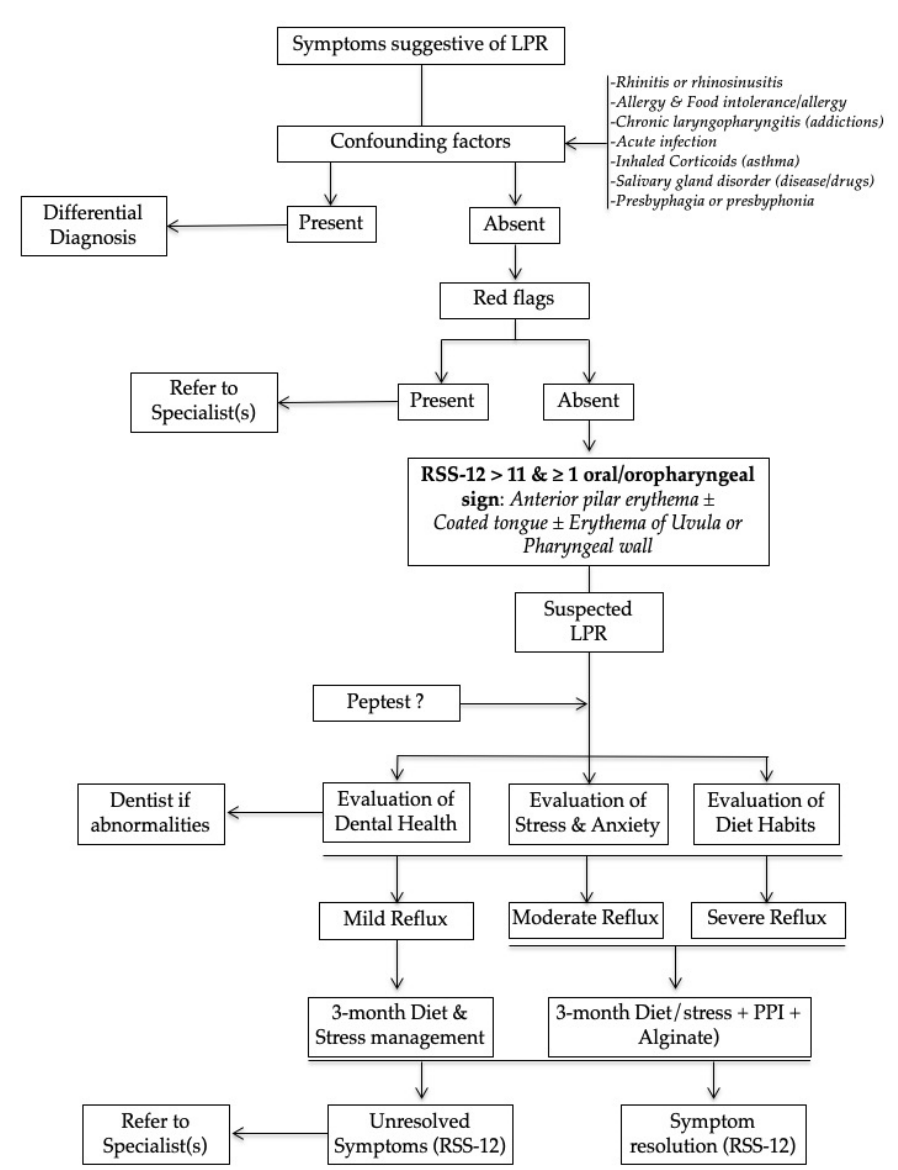
Figure 2. Practical algorithm of Management of Laryngopharyngeal Reflux in Primary care Medicine.